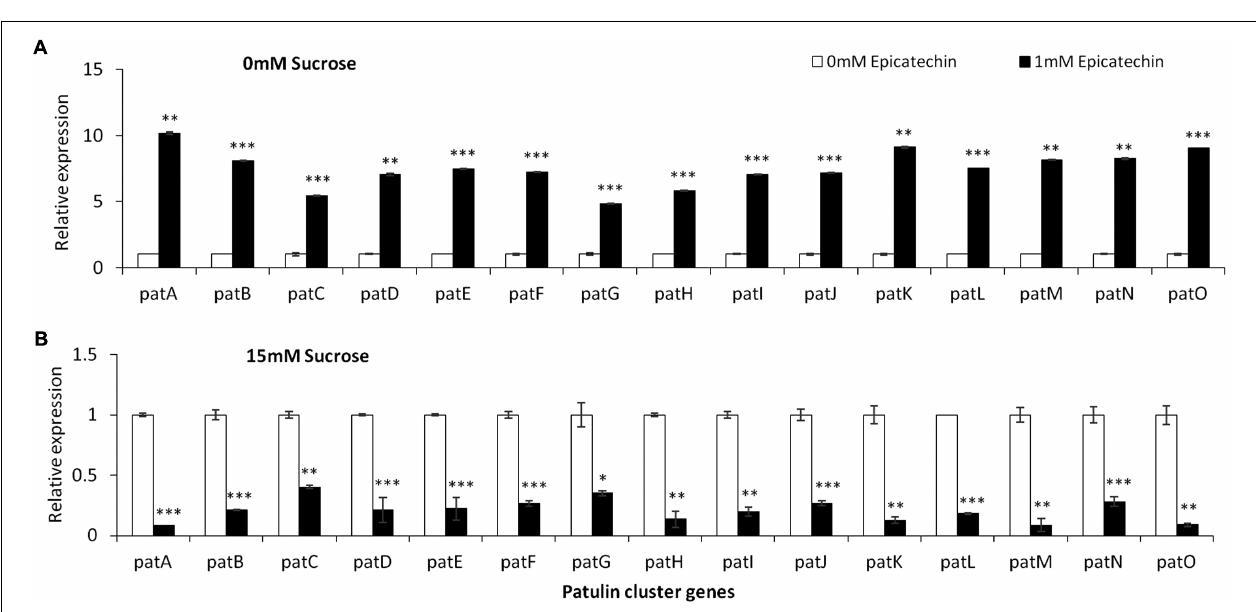
FIGURE 8 | Effect of epicatechin in absence and presence of different sucrose levels on patulin accumulation and laeA relative expression. Solid SM media at initial pH 5.0 were amended with 0, 15, 175 mM sucrose and combined with epicatechin at concentrations ranging from 0 up to 1 mM. The effect of the combination of sucrose/epicatechin was tested on laeA relative expression (RE) (A,C,E) and patulin accumulation (B,D,F) . The media was inoculated with 100 µ l of a 10 6 spore/ml suspension. Patulin and laeA relative were evaluated on the third day post-inoculation. Five 10-mm diameter disks were sampled from five independent culture plates. Average values ( ± SE) of five replicates are reported. Experiments were repeated three times and results of a single representative experiment are shown.